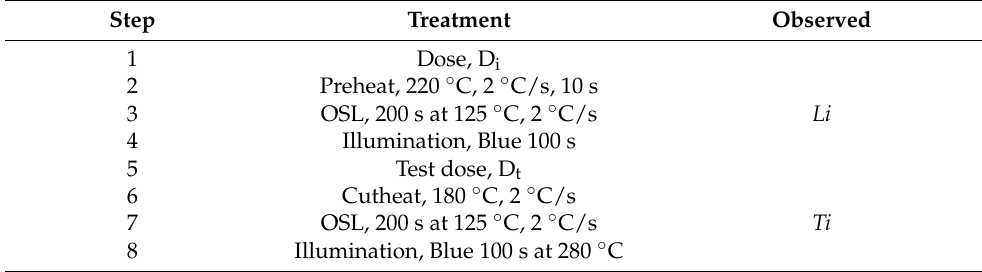
Table 1. Applied SAR protocol to